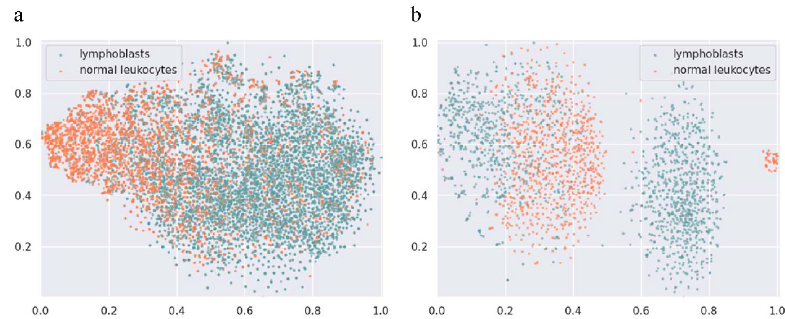
Figure 2. OpenTSNE visualizations, where the green and orange points represent lymphoblasts and normal leukocytes, respectively. ( a ) C-NMC dataset ( sample size = 10661 ); ( b ) PD dataset ( sample size = 2333 ). Cluster labels are not shown for visual clarity. Figure best viewed in color.